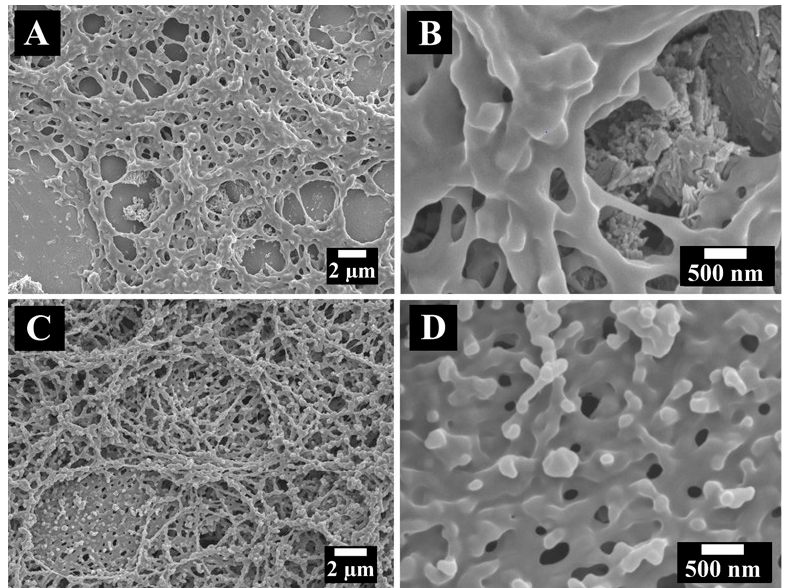
Figure 7. SEM micrographs of films at different magnifications for 10 gL − 1 PEMA solutions, with 3 gL − 1 LA and containing ( A , B ) 3 gL − 1 ibuprofen and ( C , D ) 3 gL − 1 tetracycline.